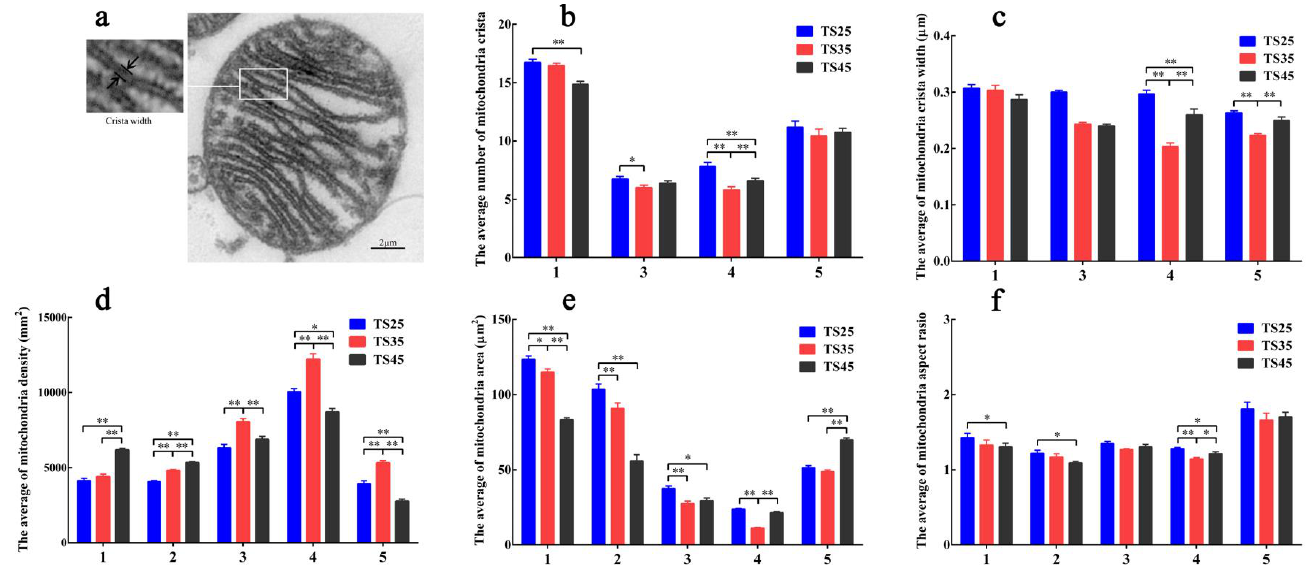
Figure 9. Analysis of five mitochondria dynamic-related indexes in five tissues of Tibetan sheep. ( a ) The structure of the mitochondrial cristae. ( b ) The number of mitochondrial cristae. ( c ) The width of mitochondria cristae. ( d ) Mitochondria density. ( e ) Mitochondria area. ( f ) Aspect ratio. ( 1 – 5 ) Heart, liver, lung, brain, quadriceps femoris. ( TS25 ) 2500 m altitude Tibetan sheep. ( TS35 ) 3500 m altitude Tibetan sheep. ( TS45 ) 4500 m altitude Tibetan sheep. Date shown on graph are means ± SEM. With the indexes in heart of TS25 as control, * p < 0.05, ** p < 0.01.